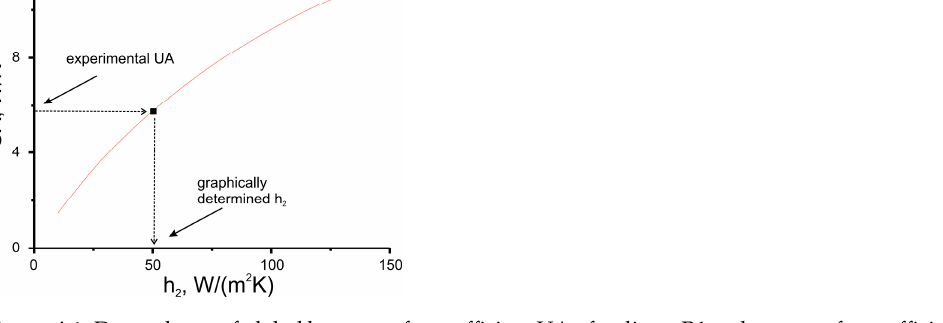
Figure A1. Dependence of global heat transfer coefficient UA of radiator R1 on heat transfer coefficient h 2 (red line) and element of experimental dataset (symbol). Arrows illustrate the principle of graphical solving of h 2 = function − 1 (UA).